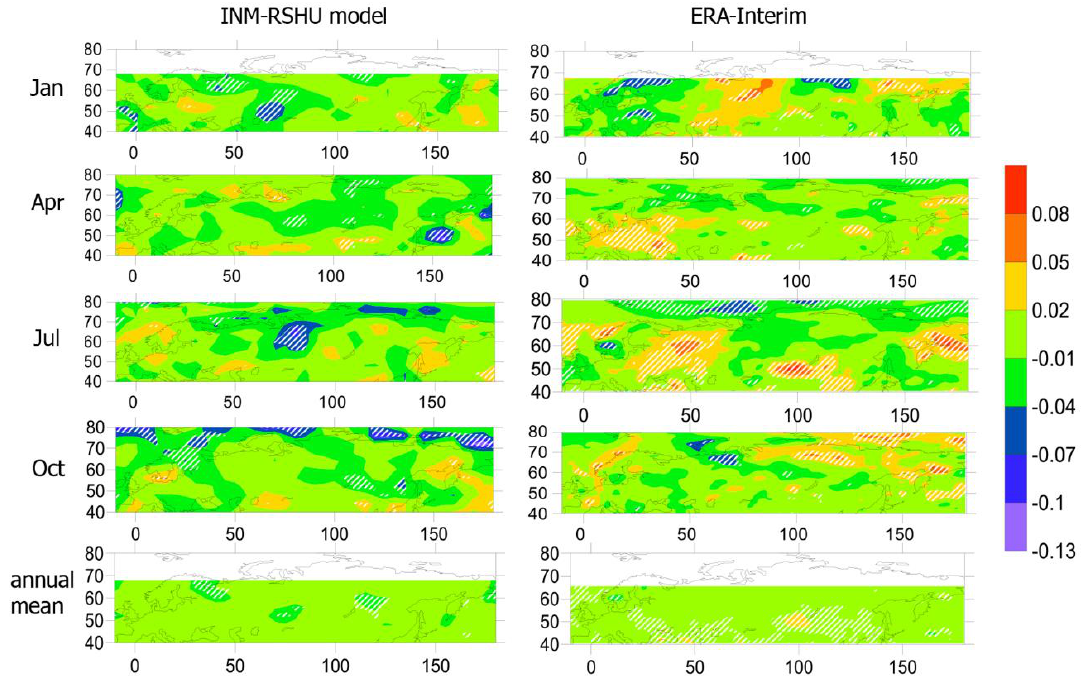
Figure 10. Di ff erence in the average of CMFuv anomalies for the period 2000–2015 and the period 1979–1999 according to the INM-RSHU CCM simulations and the retrievals from the ERA-Interim dataset. Statistically significant di ff erences at p = 95% are shown by white hatching. X -axis—is longitude, Y -axis—is latitude.